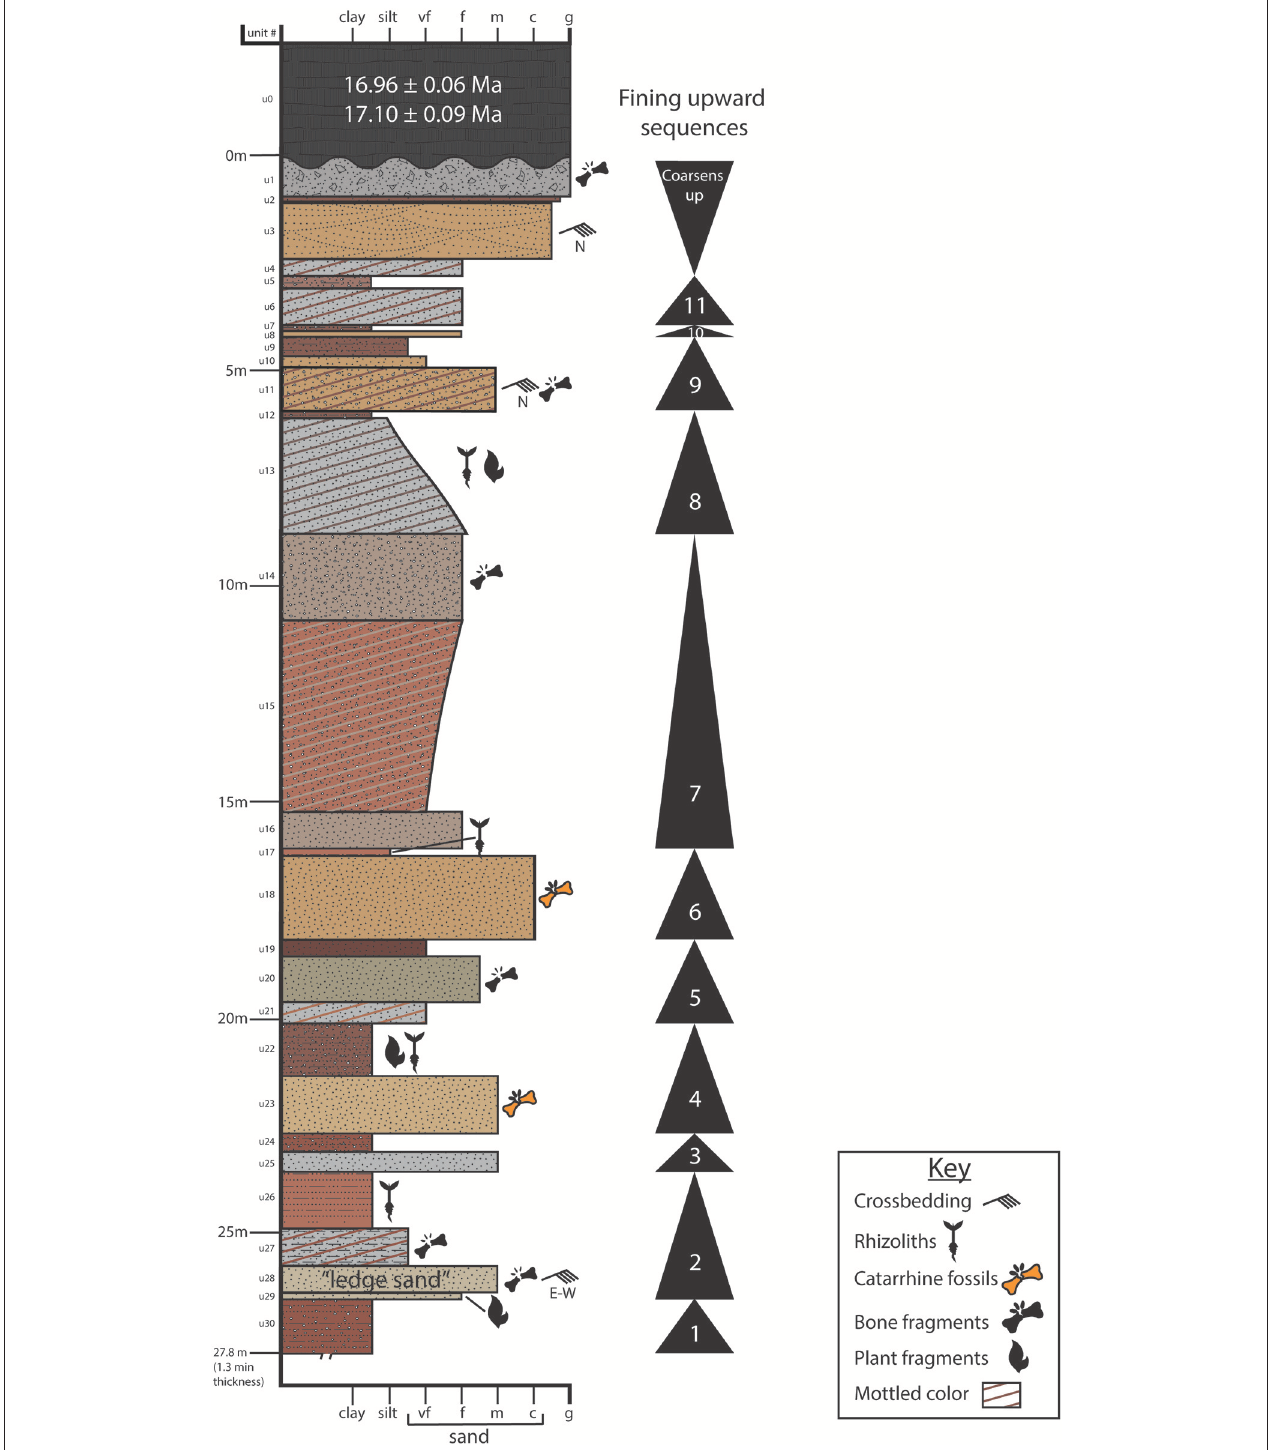
FIGURE 8 | Sedimentological description of the 28m trench excavated at site LpM4 in 2016 (trench excavation location noted on Figure 3 ). Eleven fining-upward cycles are identified, along with the presence of key sedimentary structures and fossils. Highly fossiliferous units (18, 23, and 27) sit well below the basalt (Unit 0) dated to ∼ 17Ma. Catarrhine fossils were found in stratigraphic levels correlated to Units 18 and 23.